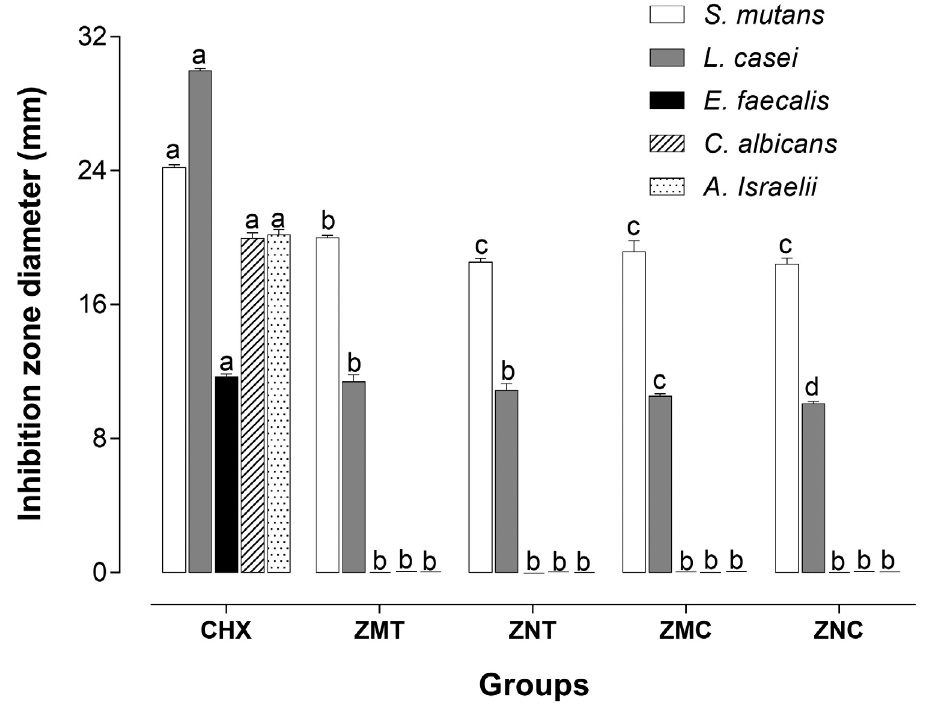
Figure 1- Mean values (SD) of inhibition zone diameters according to the microorganisms and the different cement formulations. Different lowercase letters show statistical differences between the groups for each bacterial species (Kruskal-Wallis, Student-Newman-Keuls test,